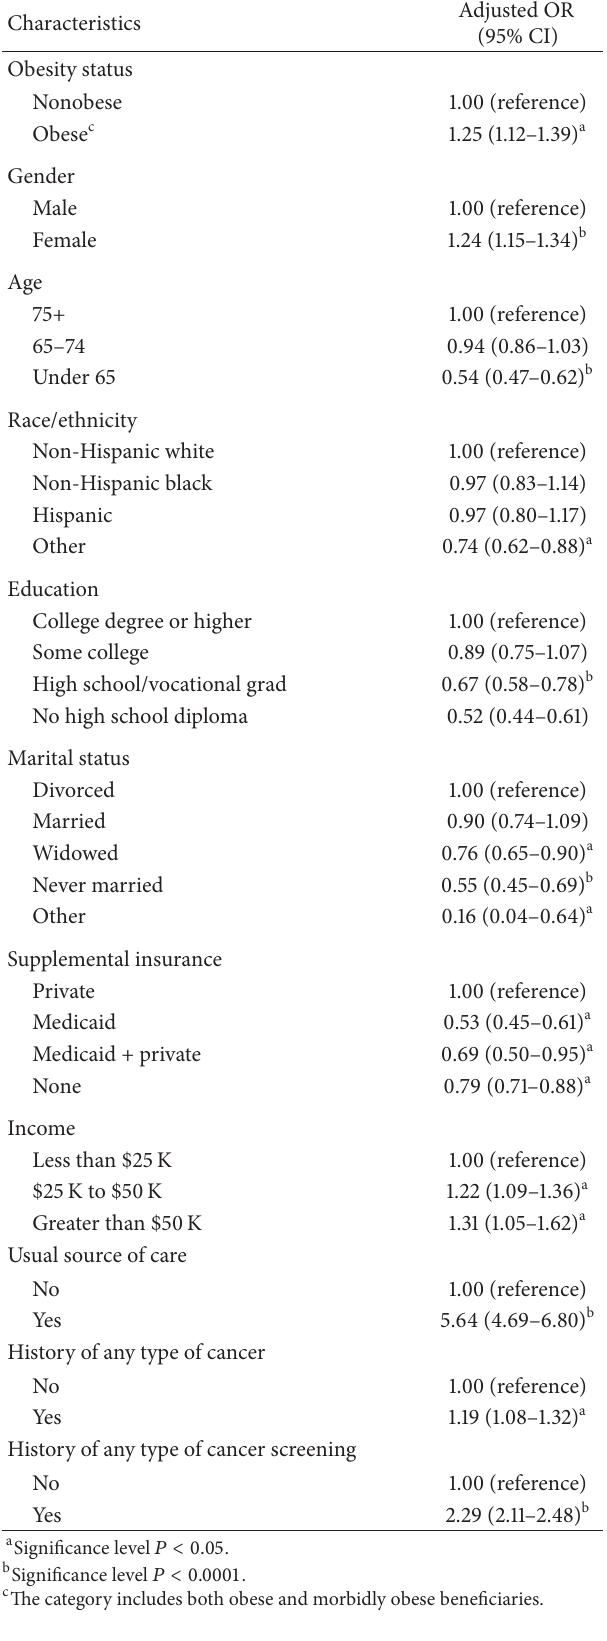
Table 3: Factors associated with CRC Screening among medicare beneficiaries in